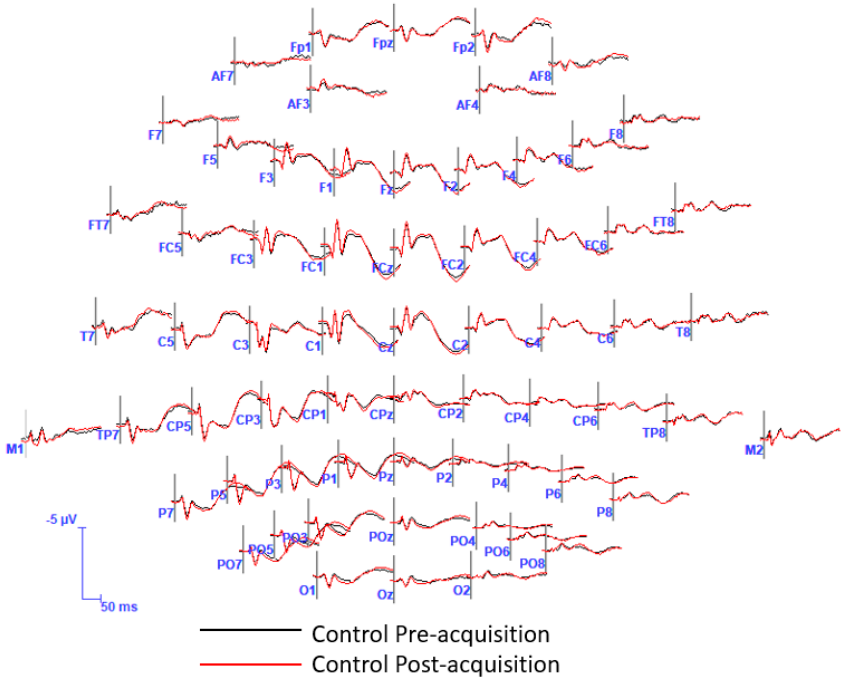
Figure A2. Depiction of the FMT pre (baseline) and post grand-average ERP waveforms for those in the Control group. This illustrates the scalp activity within all electrodes from a latency period of—10 ms to 200 ms after median nerve stimulation.